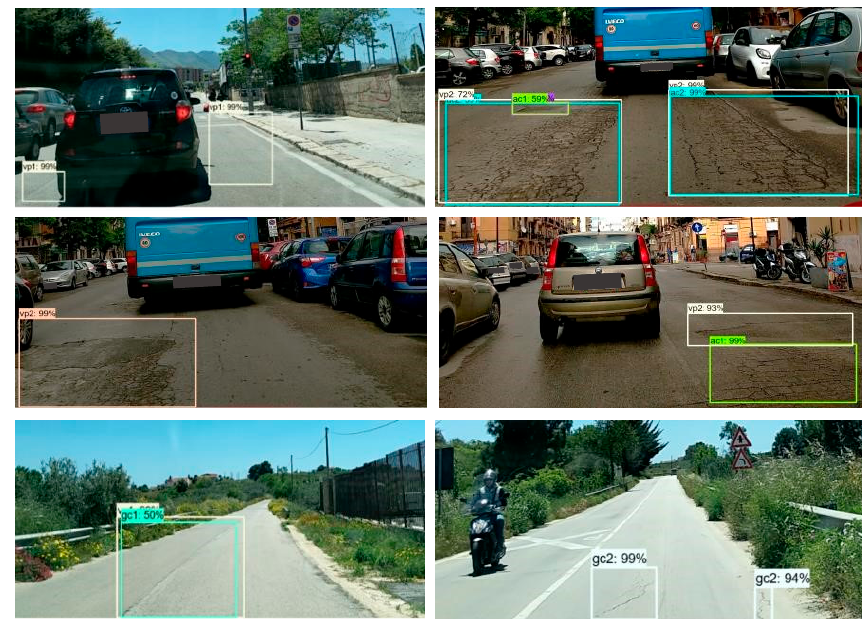
Figure 13. Faster R-CNN with inceptionv2 model predictions on test data.